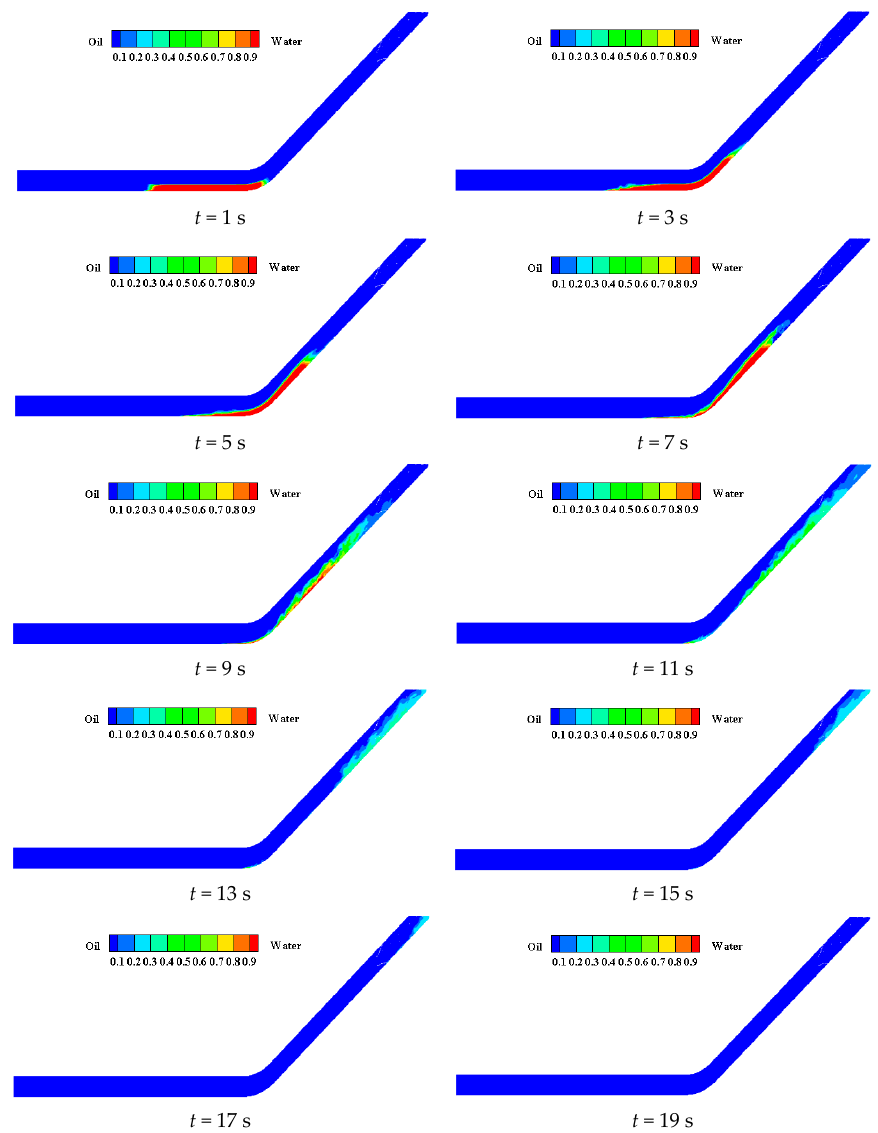
Figure 9. Phase distribution of water-carrying process ( α = 30°).